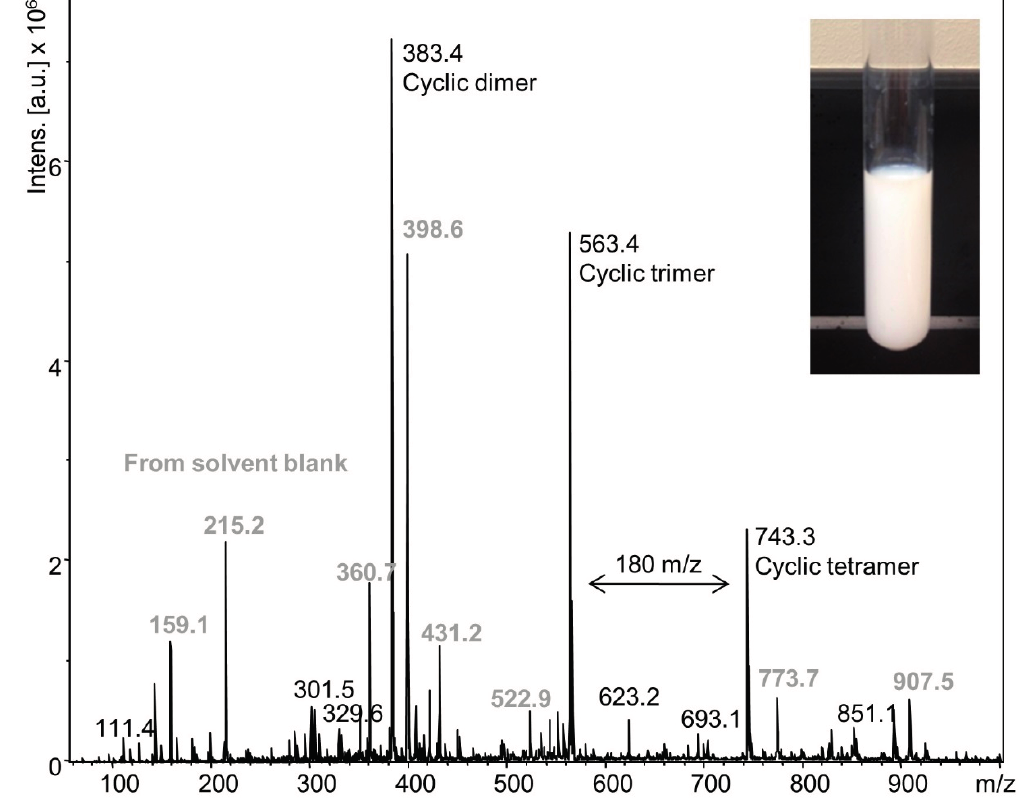
Figure 8. ESI-MS spectrum of emulsion from the low temperature (15 °C)